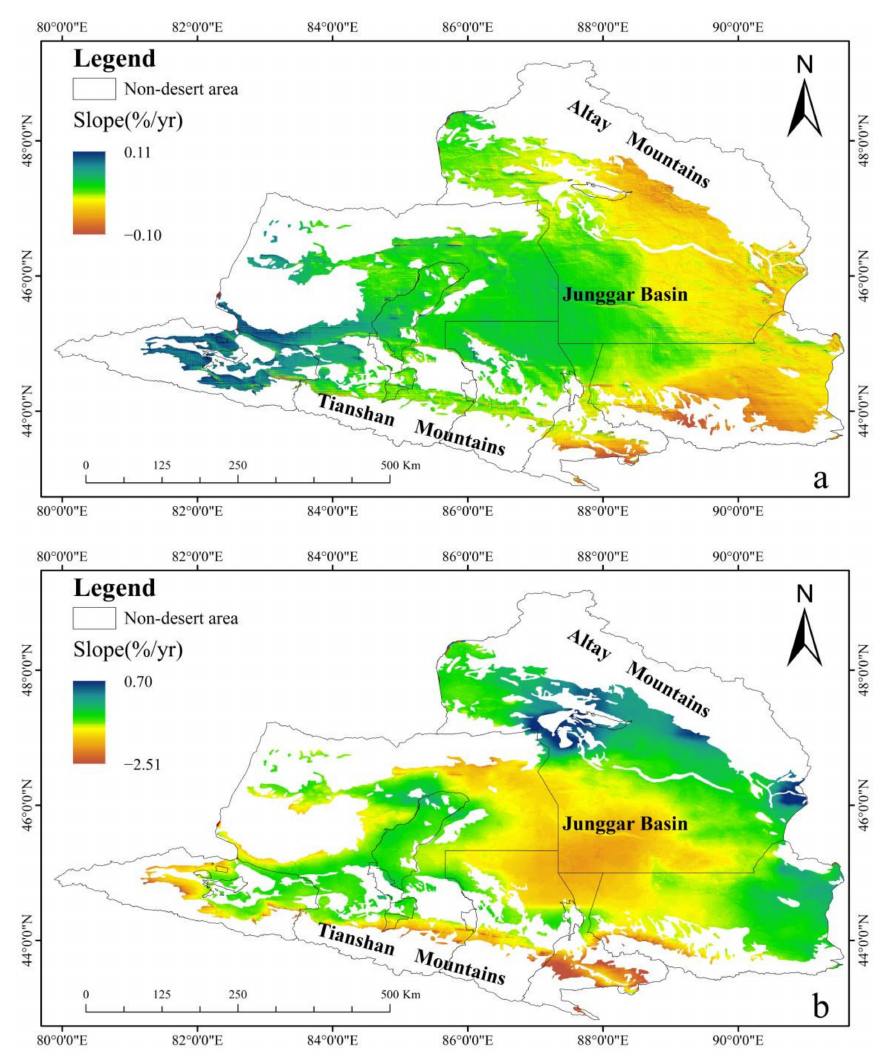
Figure 6. Variation trend of annual mean temperature ( a ) and cumulative precipitation ( b ) in Junggar Basin Desert Area from 2000 to